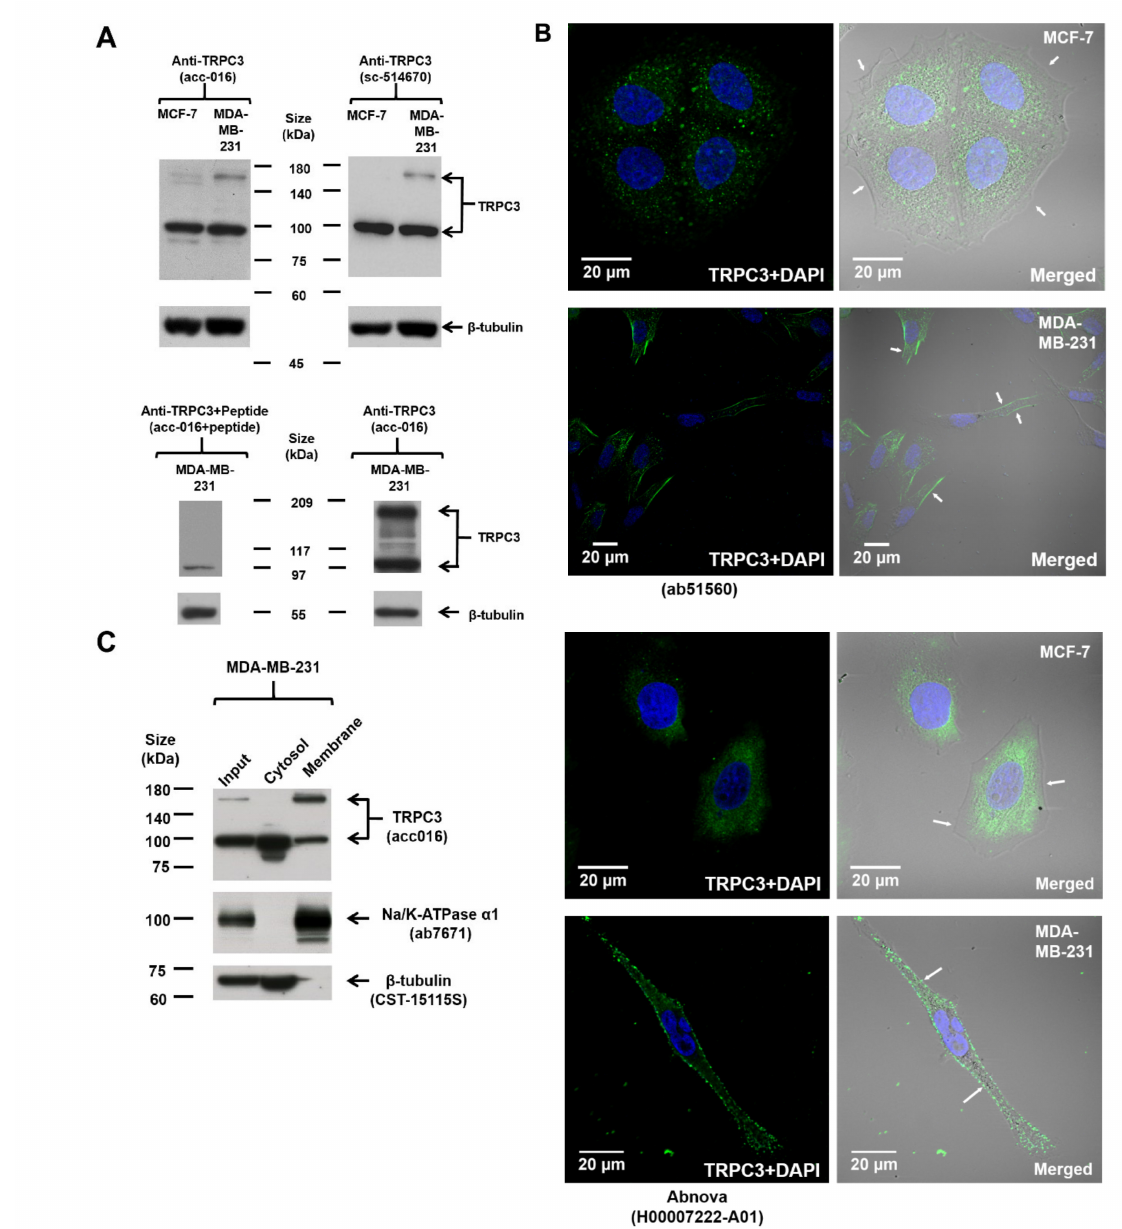
Figure 1. TRPC3 was over-expressed on the plasma membrane of MDA-MB-231. ( A ) representative Western blots showing the expression of TRPC3 in MCF-7 and MDA-MB-231. TRPC3 protein (~100 kDa) was expressed in both MCF-7 and MDA-MB-231, whereas TRPC3 protein represented by the band between 140 and 180 kDa was over-expressed in MDA-MB-231. Membranes were incubated with two di ff erent TRPC3 antibodies (Alomone Labs, Jerusalem, Israel and Santa Cruz, Dallas, TX, USA) and consistent expression patterns were detected. β -tubulin was used as an internal control. Corresponding bands became faded or disappeared when the membrane was incubated with TRPC3 antibody pre-incubated with its corresponding peptide antigen (Alomone Labs), suggesting the specificity of the bands. ( B ) representative confocal images showing the subcellular localization of TRPC3 (green) in MCF-7 and MDA-MB-231. Cells were incubated with two di ff erent TRPC3 antibodies (Abcam, Cambridge, UK and Abnova, Taipei, Taiwan). Nuclei were stained with DAPI (blue). Merging fluorescence images with bright field images revealed that TRPC3 was over-expressed on the plasma membrane of MDA-MB-231 when compared to MCF-7. Plasma membrane positions were indicated by white arrows. Scale bar: 20 µ m. ( C ) subcellular fractionation followed by Western blot analysis confirmed that the over-expressed TRPC3 protein represented by the band between 140 and 180 kDa was enriched in the membrane fraction of MDA-MB-231. Na / K-ATPase α 1 was used as a membrane protein marker and β -tubulin was used as a cytosolic protein